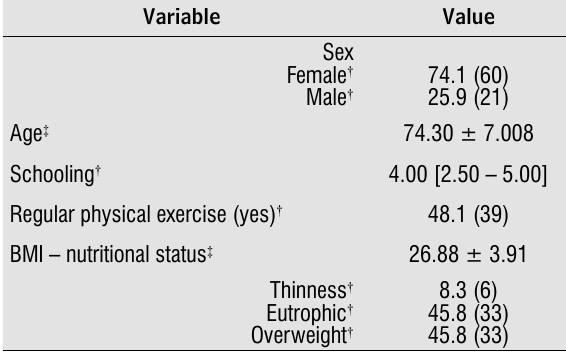
Table 1 – Characterization of the sample and risk of falls identified by QuickScreen and SPPB at baseline (n =